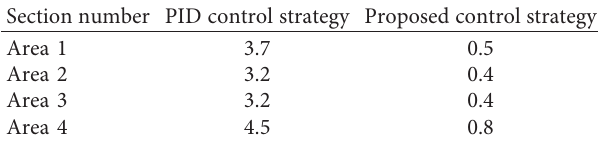
Table 6: Frequency deviation ITAE index values in each region. Section number PID control strategy Proposed control